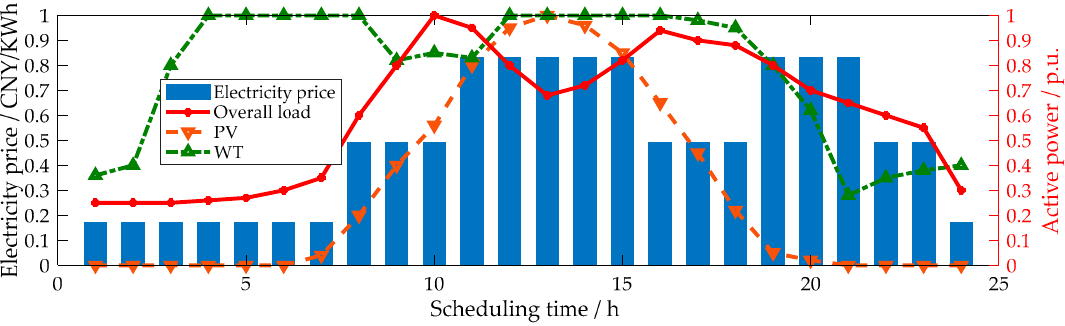
Figure 8. Time-of-use price curve and daily forecasting curve of loads, WTs, and PV cells.